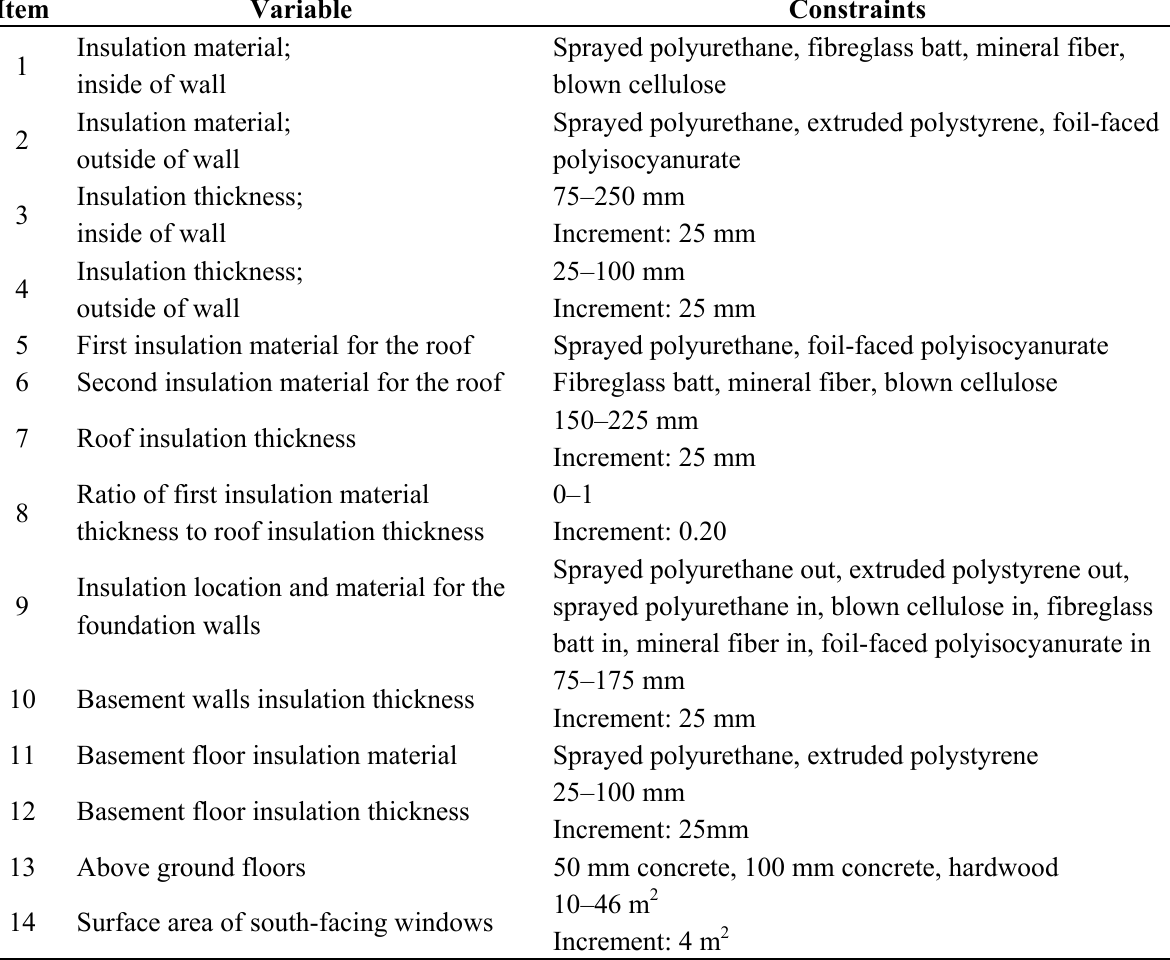
Table 3. Optimization